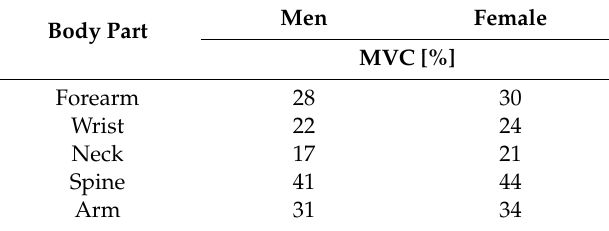
Table 3. Mean %MVC values of selected farmer’s muscle groups during silage transport to the